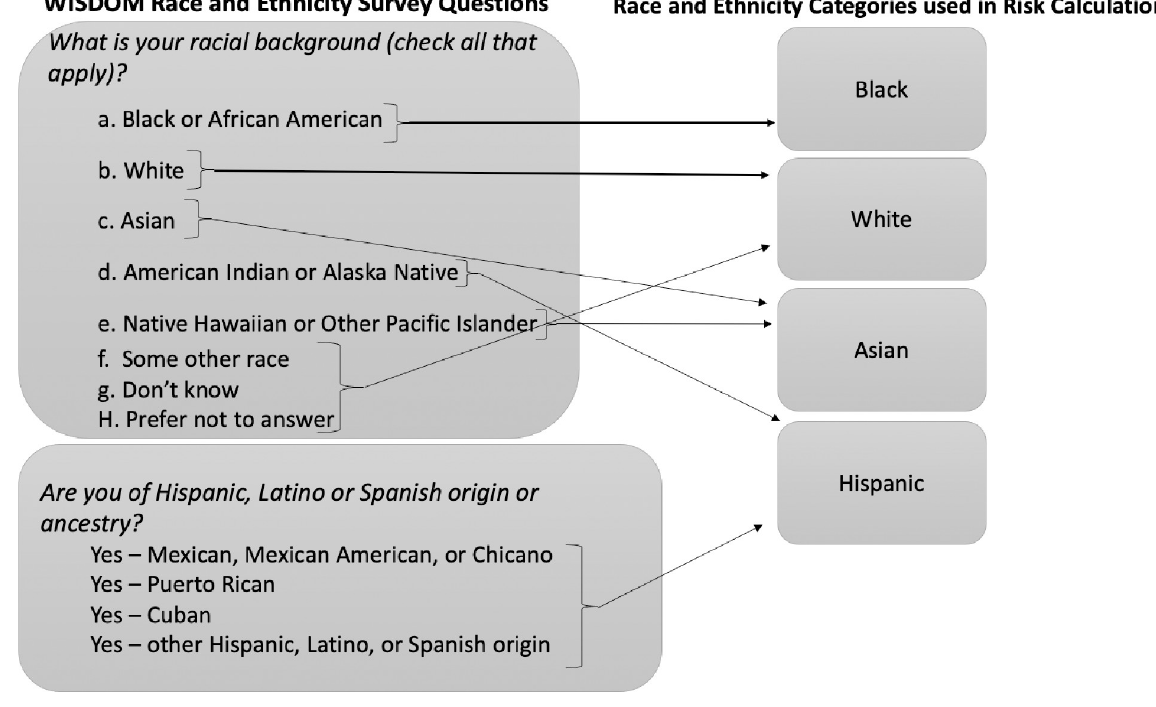
Fig 4. WISDOM race and ethnicity